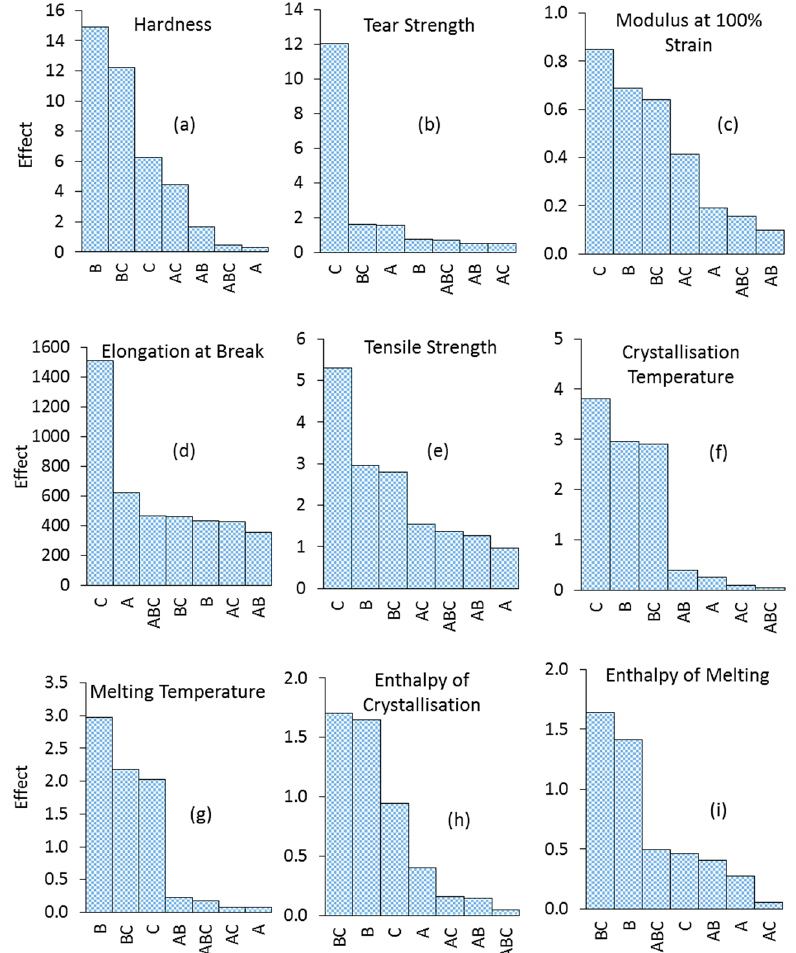
Figure 12. Pareto charts illustrating the effects of ageing factors (A: strain, B: medium, C: temperature) and their two- and three-way interactions (AB, AC, BC, ABC) on the SR properties.